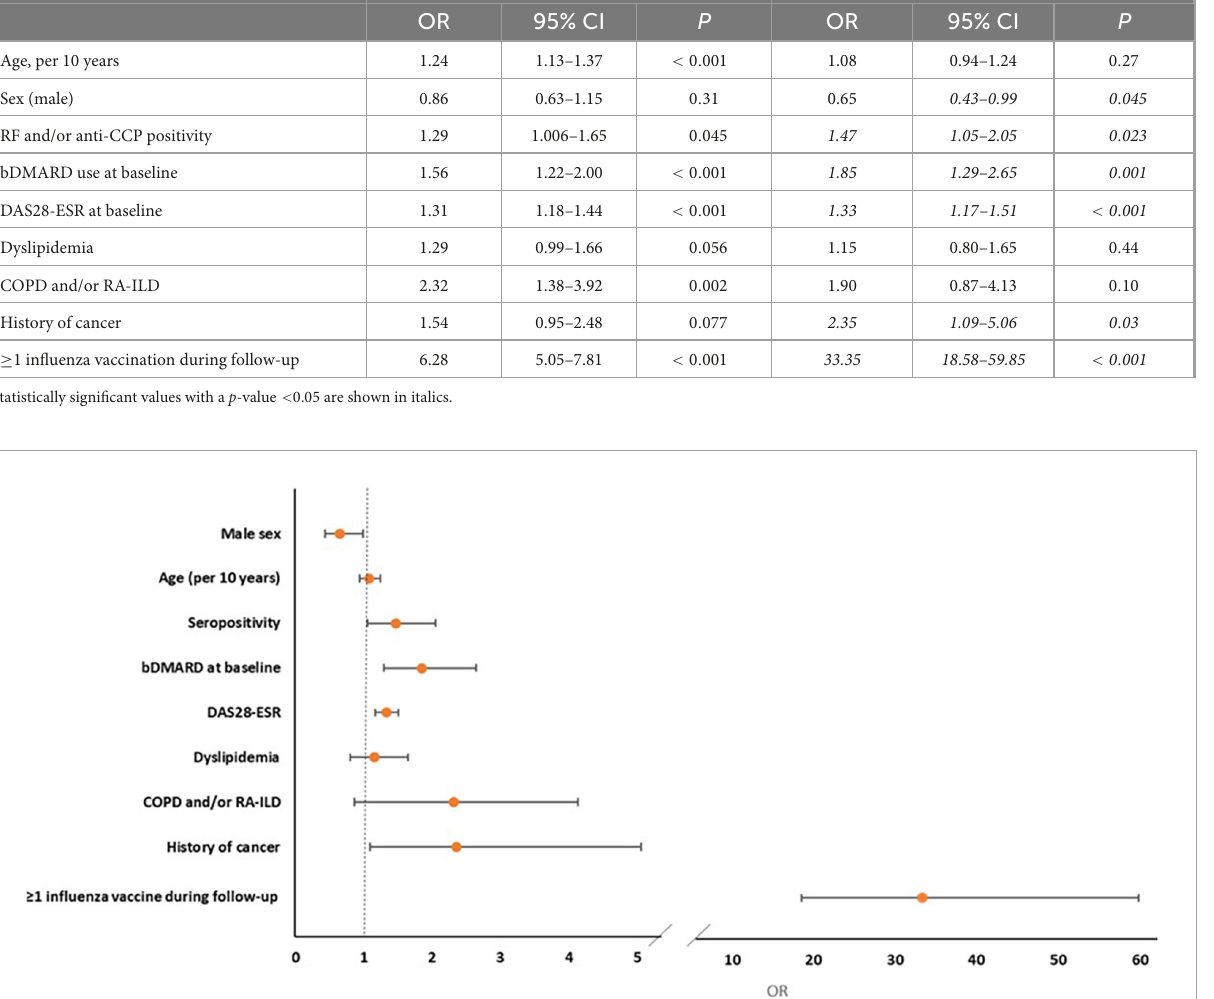
23.5% for PPSV23 coverage (21). Given the suboptimal